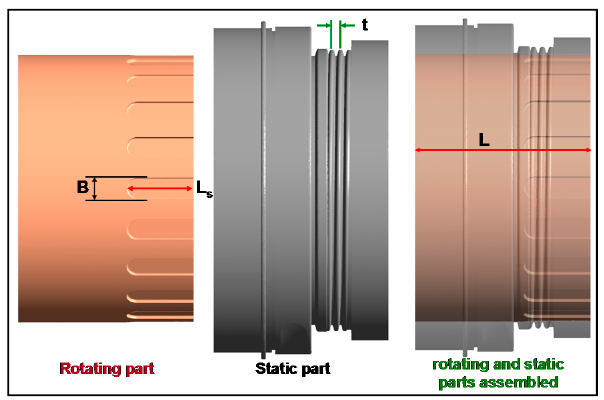
Figure 1. The windback seal components (Rotor with scallops, static part with thread and the assembly).